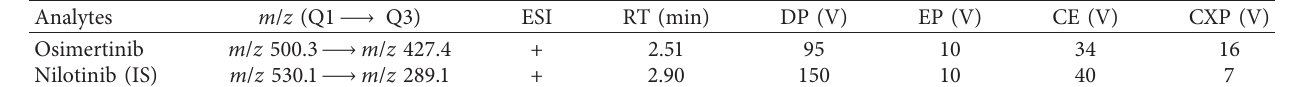
Table 1: General mass spectrometric settings for the osimertinib and internal standards.